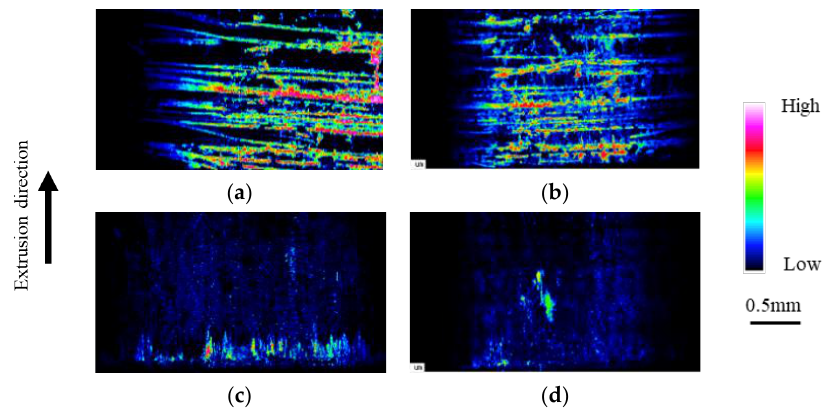
Figure 10. Evaluation of adhesion to punch via EPMA for 5 μm -textured punch: ( a ) 1st and ( b ) 5th extrusion; nanometer-textured punch: ( c ) 1st and ( d ) 5th extrusion.